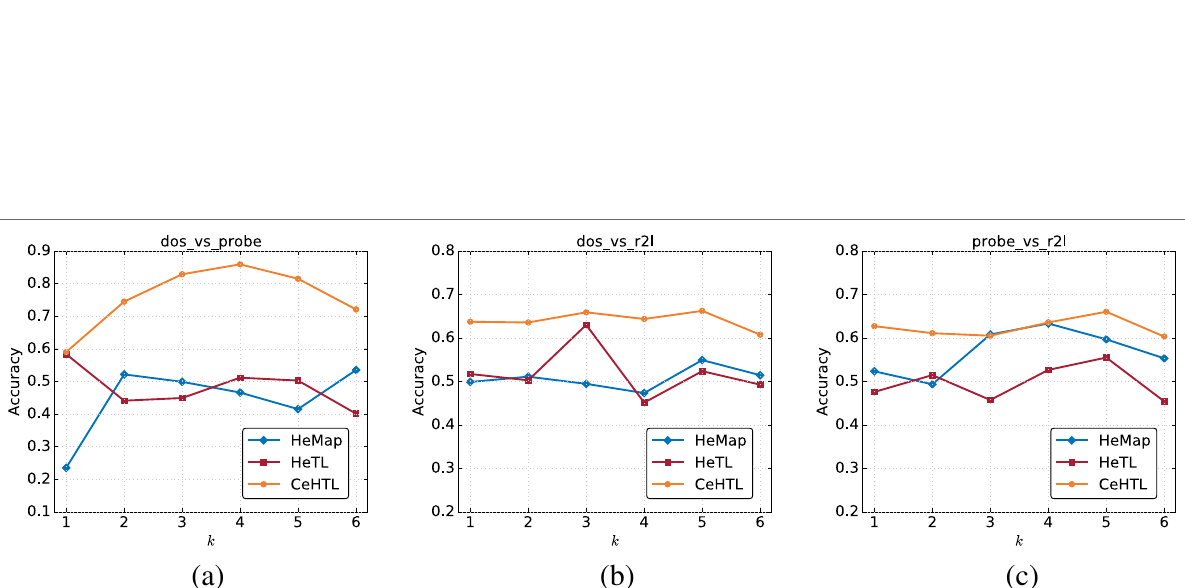
Fig. 11 Study of parameter k sensitivity on the three main detection tasks, sample = 1000. a DoS → Probe. b DoS → R2L. c Probe →